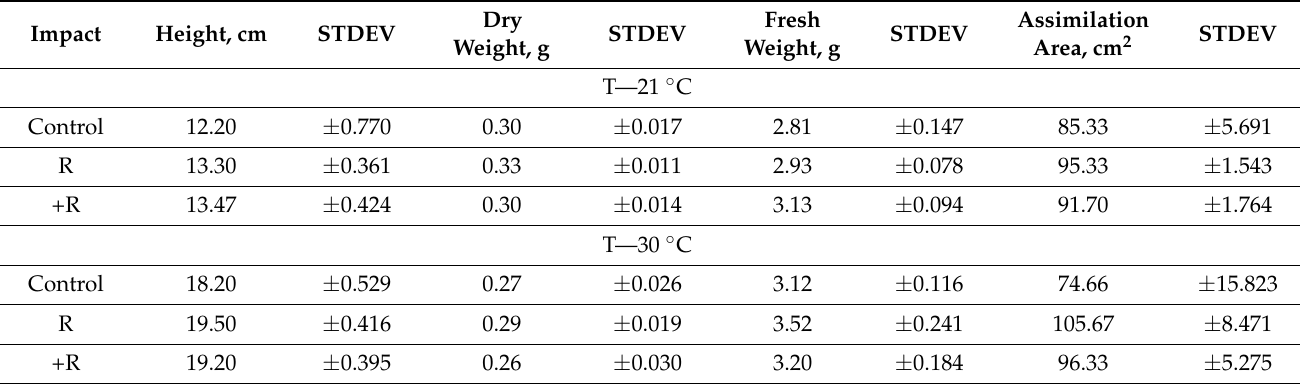
Table 1. Growth parameters of tomato cultivated under combinations of different temperature and HPM